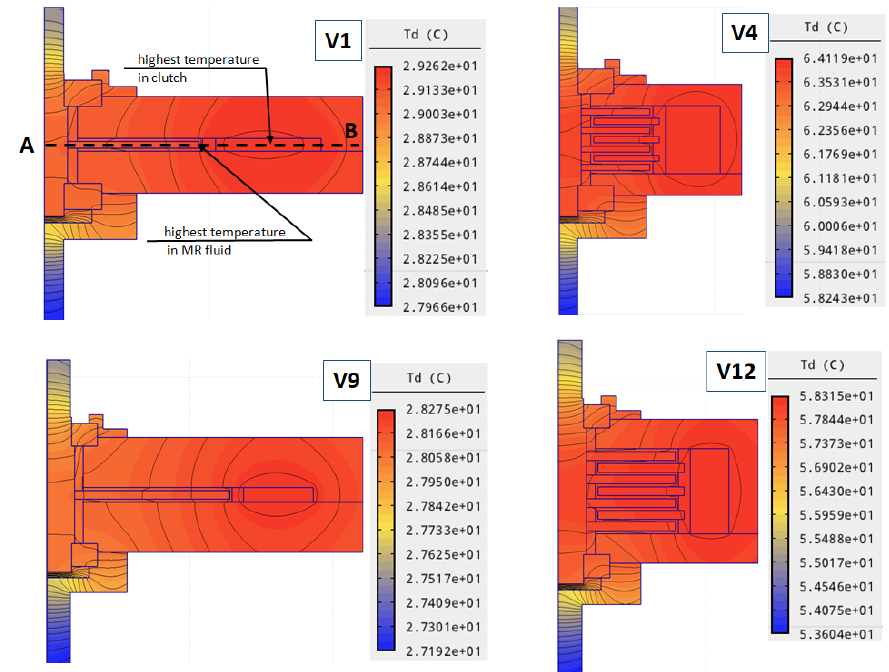
Figure 9. Spatial temperature distribution in steady state for selected representative variants: V1 , V4 , V9 and V12 .